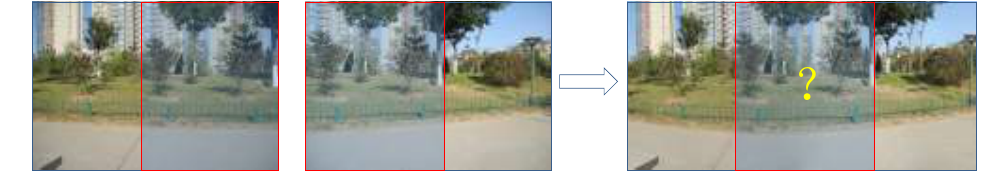
Figure 3. It’s hard to decide the exact relation between original and merged images.